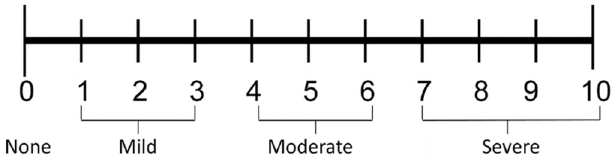
Figure 1. The used numerical rating scale (Mc Caffery et al., 1989).